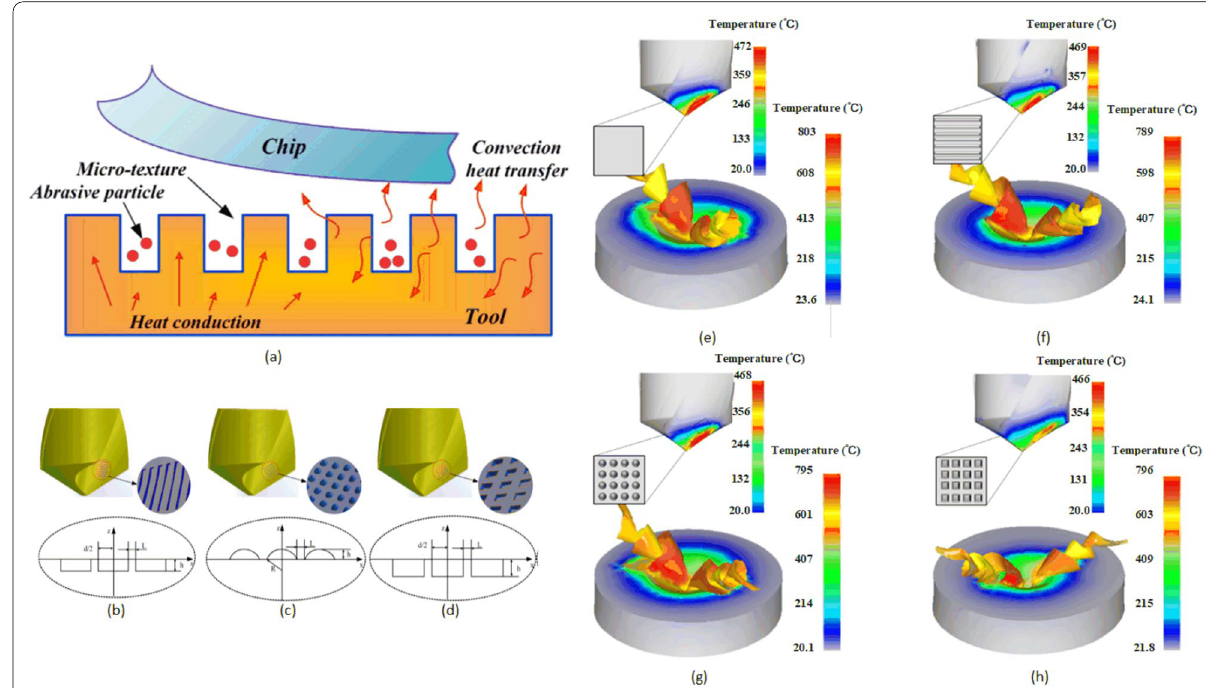
Figure 20 The research on drilling temperature with differently micro-textured drilling tools: a Schematic diagram of micro-texture anti-friction and heat conduction mechanism, b – d Micro-texture section shape of drilling tools of grooved micro- texture, convex micro-texture and pit micro-texture, e – h Temperature distribution of drilling process with non-micro-textured drilling tool and different micro-textured drilling tool [95]